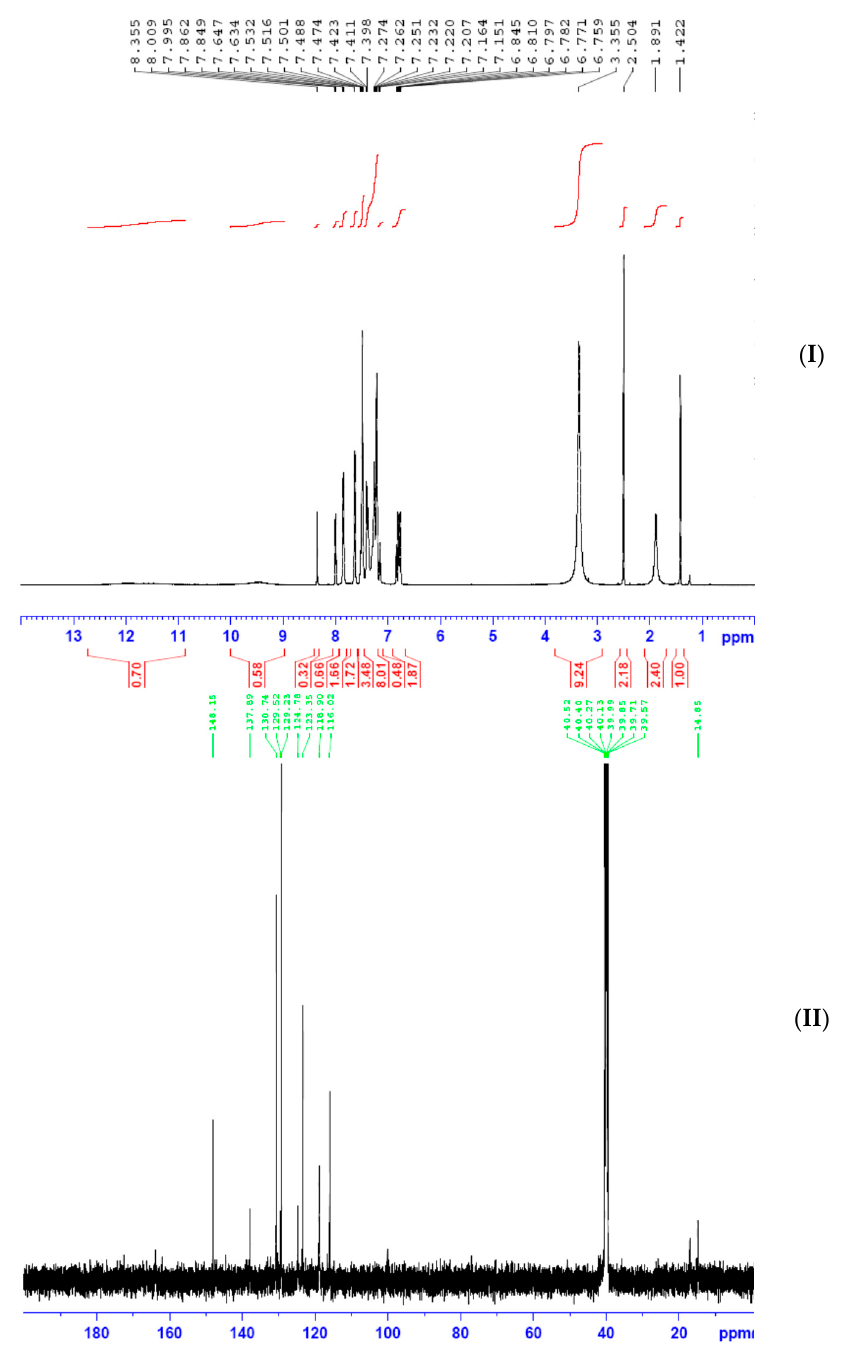
Figure 5. ( I ) 1 H NMR spectrum of Bmpp-Ph; and ( II ) 13 C NMR spectrum of Ampp-Dh.